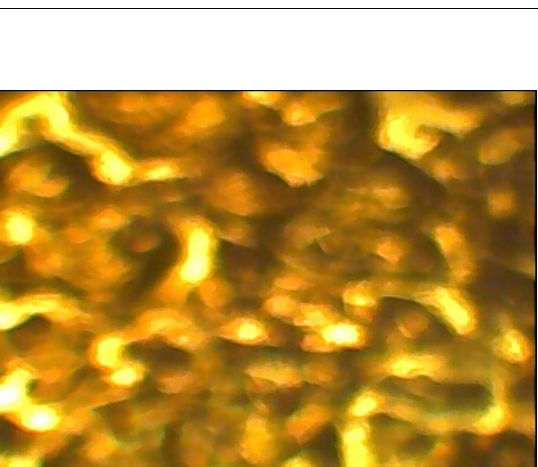
Figure 11: Microstructure of the sample quenched in 500 ml of cottonseed oil and 500 ml of neem seed oil